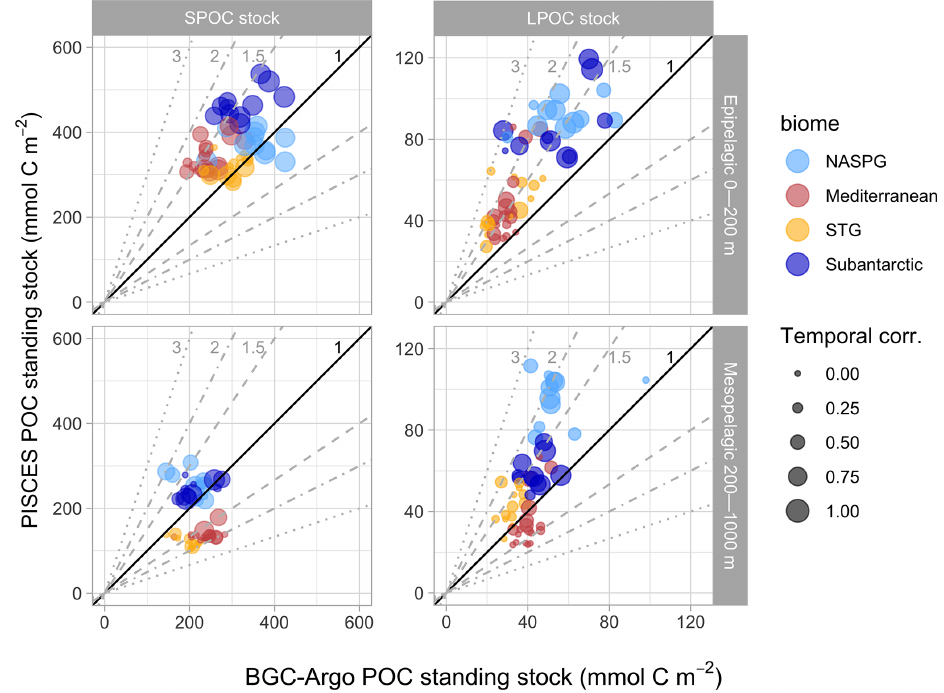
Figure 8. Mean annual POC stocks. BGC-Argo versus PISCES scatterplots are shown for the standing stocks (vertical integrals) of small POC (SPOC) and large POC (LPOC) in the epipelagic (0–200m) and mesopelagic (200–1000m) layers. Reference lines indicate a range of model / data ratios, from 1 : 1 (perfect correspondence) to a factor of 3 or its inverse. Biomes are distinguished with different colors, and the size of the circles is proportional to the temporal correlation between BGC-Argo and PISCES stocks at each location (as shown in the bottom panels of Figs. 6 and